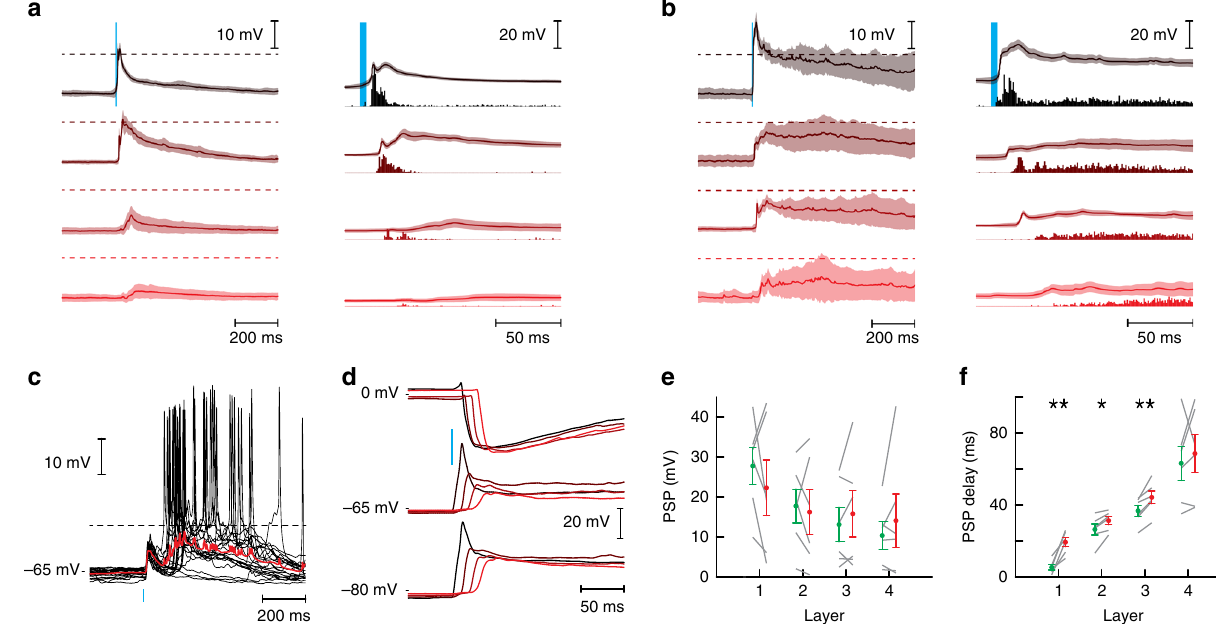
Fig. 6 PSP dynamics in multilayer networks. a Average postsynaptic potential of neurons in sparse networks. Data were averaged from n = 6 networks (density = 342 ± 57 neurons·mm − 2 , mean ± STD) where a single neuron was recorded in layers 1 – 4 (black to red) of each network. The shaded area represents the standard deviation averaged over trials and then averaged over neurons. The dashed line represents the average spiking threshold of 15 mV above resting membrane potential 37 . Right: same data shown at higher temporal magni fi cation and superimposed with the PSTHs from Fig. 2. b Same as in a but for dense networks ( n = 5 networks, density = 572 ± 117 neurons·mm − 2 , mean ± STD). c Recordings from a neuron in layer 2 showing variability in the subthreshold potentials leading to threshold crossings (22 trials, mean membrane potential shown in red). d Example of excitatory (bottom), inhibitory (top), and compound (middle) post-synaptic potentials in a neuron when the light stimulus was delivered in layers 1 – 4 (black to red). e EPSP and IPSP amplitudes recorded simultaneously in layers 1 – 4 vs layer ( n = 6 networks, density = 510 ± 131 neurons·mm − 2 , mean ± STD). Amplitudes between individual EPSPs and IPSPs were correlated (Pearson correlation: R = 0.75, P = 2.1 × 10 − 5 , n = 24). Gray lines mark individual measurements. f PSP delay (stimulus onset to time at maximal slope) vs layer. Paired t -test statistic for the difference between E and I delays: L1: P = 0.002, L2: P = 0.012, L3: P = 0.003, L4: P = 0.51. * P < 0.05, ** P < 0.01 In e , f , data are presented as mean ± SEM and individual data are shown as gray